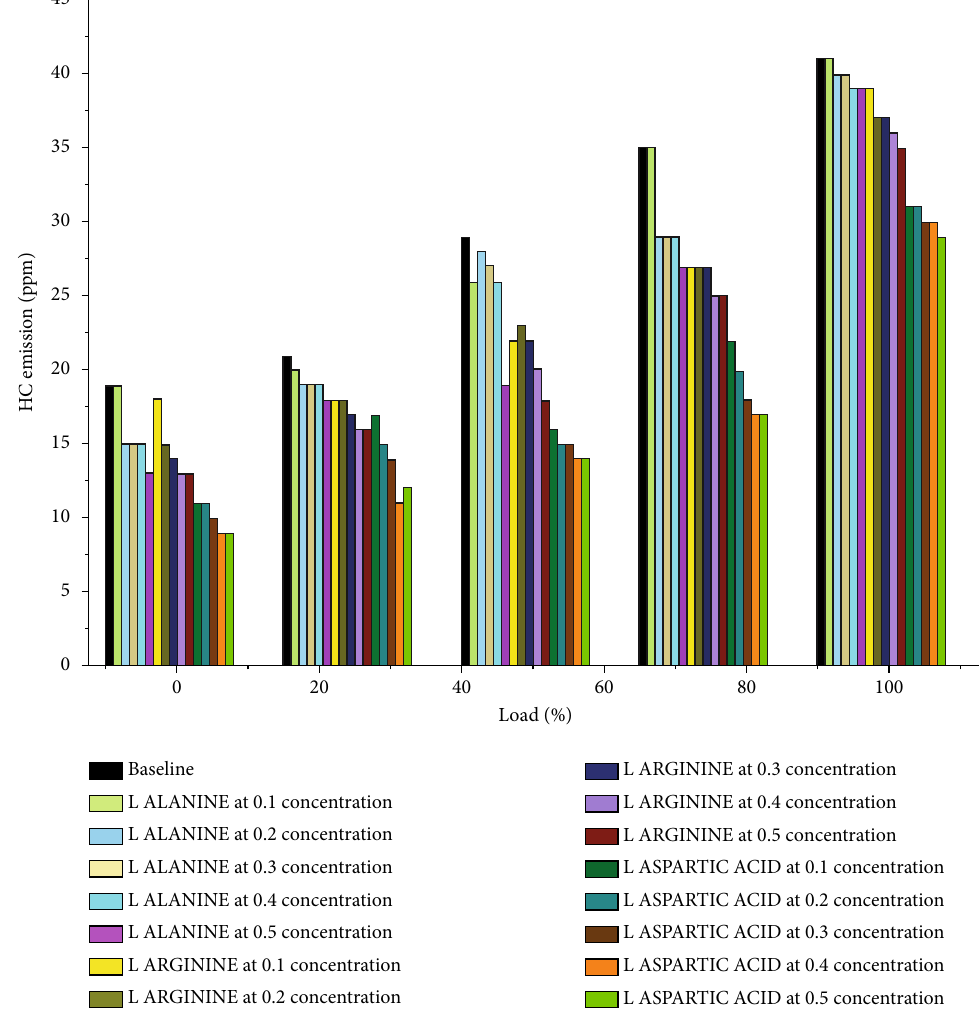
Figure 10: The di ff erence in hydrocarbon with respect to engine